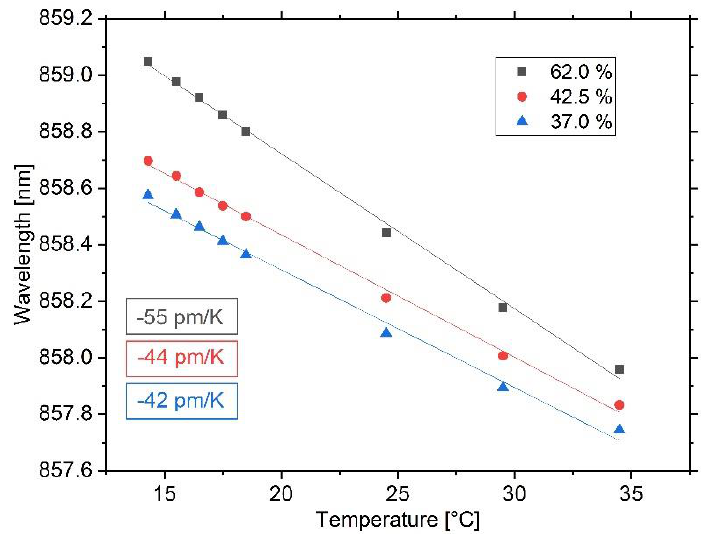
Figure 9. Result of the temperature sensitivity experiment for the three humidity levels. The Bragg grating is heated locally, while the surrounding environment maintains a constant temperature and humidity. At all humidity levels, the sensor shows a linear blueshift, but with increasing sensitivity for higher relative air humidity.